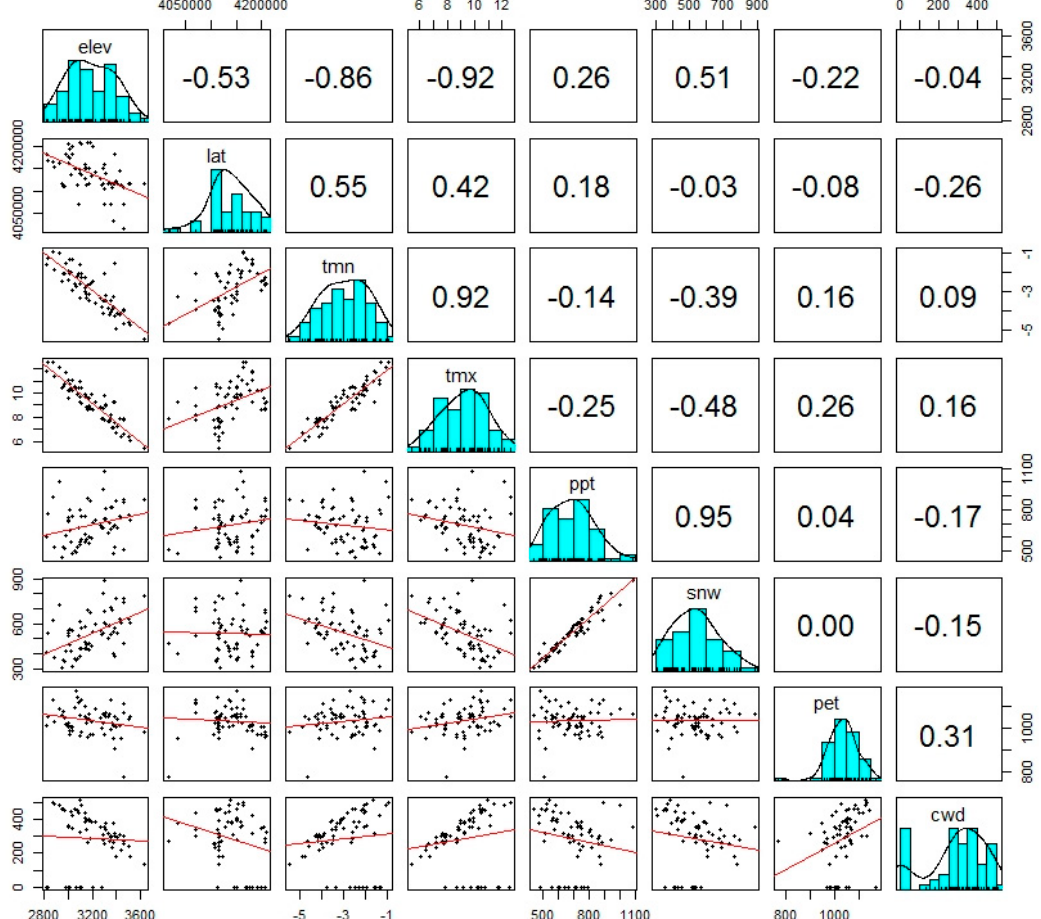
Figure 3. Scatterplot matrix of climate variables, including variable distributions, simple linear fits, and Pearson coefficients. elev = elevation and lat = latitude (m); tmn = mean minimum temperature and tmx = mean maximum temperature (°C); ppt = total annual precipitation, snw = total annual snowfall, pet = potential evapotranspiration, and cwd = climatic water deficit (all in units of cm).